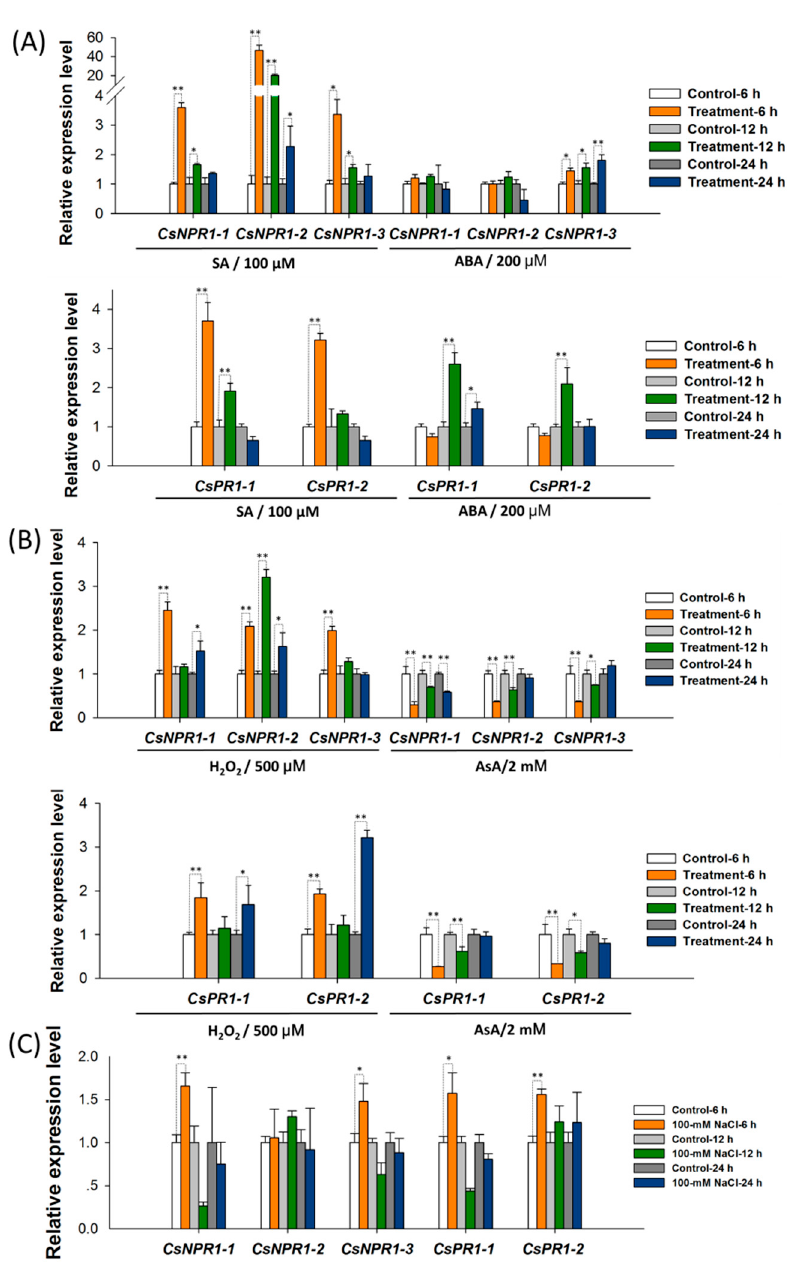
Figure 5. Expression analysis of CsNPR1 and CsPR1 genes in response to SA, ABA, H 2 O 2 , AsA and salinity stress induction by qRT-PCR. Cymbidium protoplasts were treated with ( A ) SA and ABA, ( B ) H 2 O 2 and AsA, as well as ( C ) abiotic stresses (NaCl, sodium chloride for salinity stress), and the relative expression levels of CsNPR1 and CsPR1 genes were measured by qRT-PCR. Y-axes indicate the relative expression levels; significant difference was assessed by Mann–Whitney U-test and indicated by asterisks; single asterisk (*) represents p ≤ 0.05, double asterisk (**) represents p ≤ 0.01; Data are expressed as the mean of three biological replicates, with error bars indicating the SD.